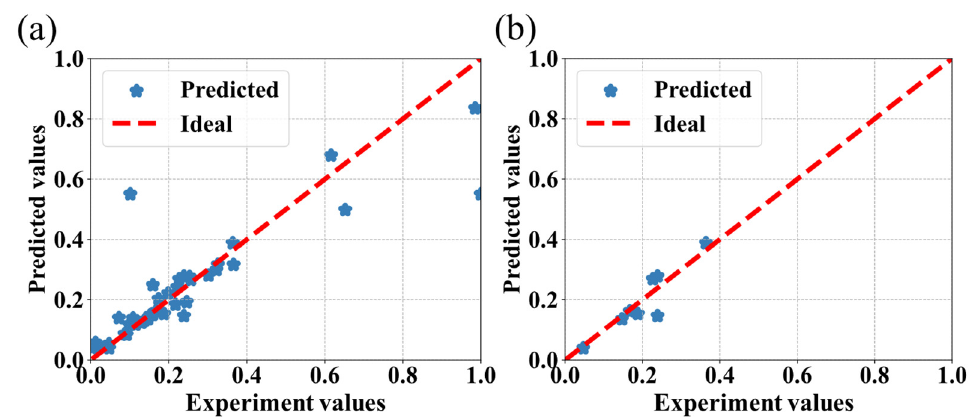
Figure 6. Performance of the RF algorithm for the prediction of the IBU loading capacity of MOFs associated with the experimental values. ( a ) The predictions are calculated on the entire dataset. ( b ) The predictions are exclusively calculated on the testing dataset.